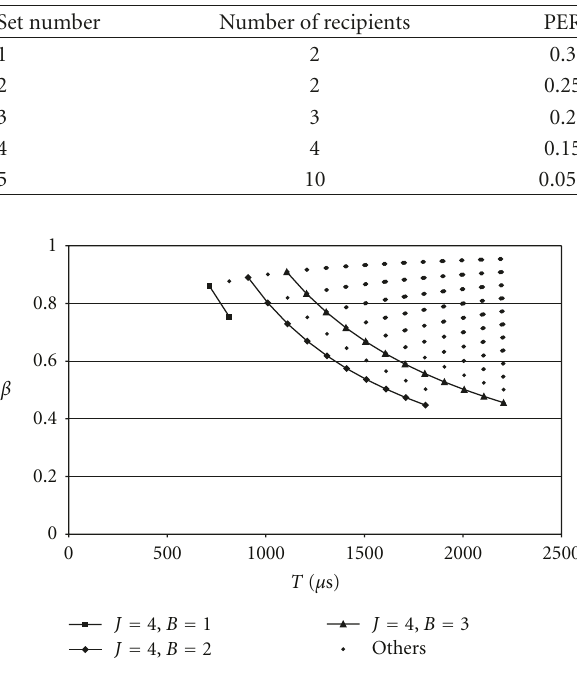
Table 1: Recipient’s PER distribution.